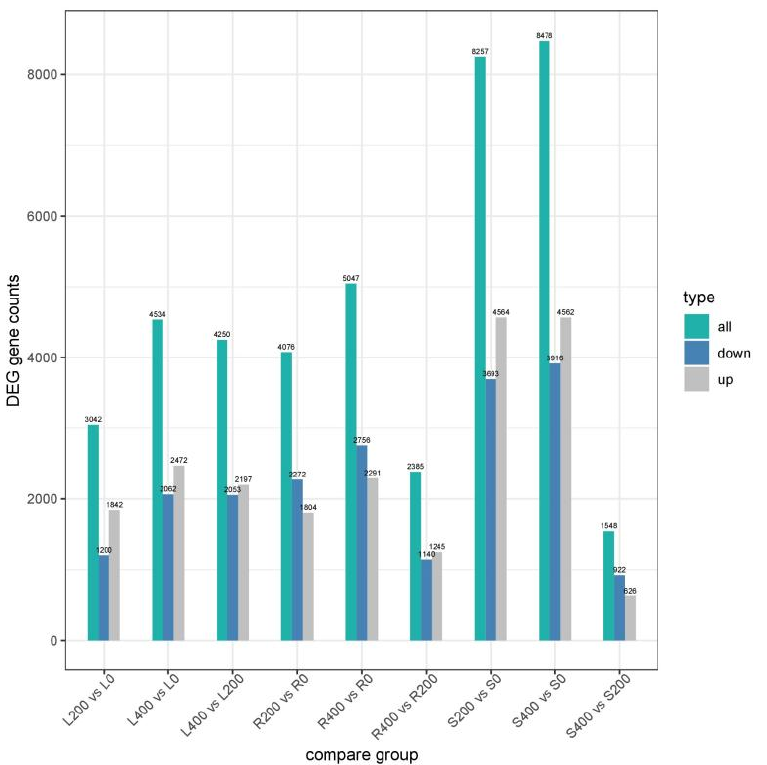
Figure 2. Differentially expressed genes of P. talassica × P. euphratica in different comparison groups.